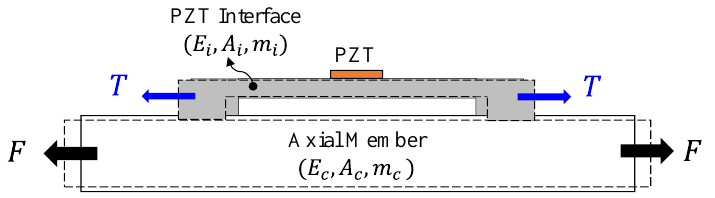
Figure 2. Piezoelectric interface attached to an axial member under tension.